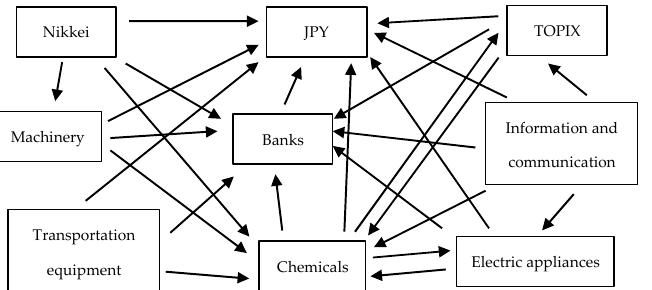
Figure 4. Author’s estimations based on the data from the Bank of Japan, TSE and Yahoo Finance. The arrows show the direction of causality in variance.